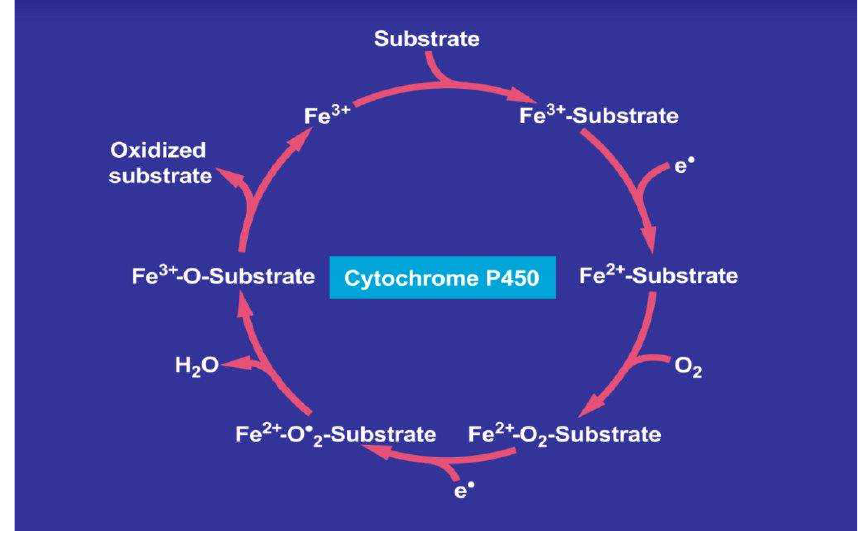
Figure 1. Catalytic CYP cycle of hepatic microsomal drug metabolism.